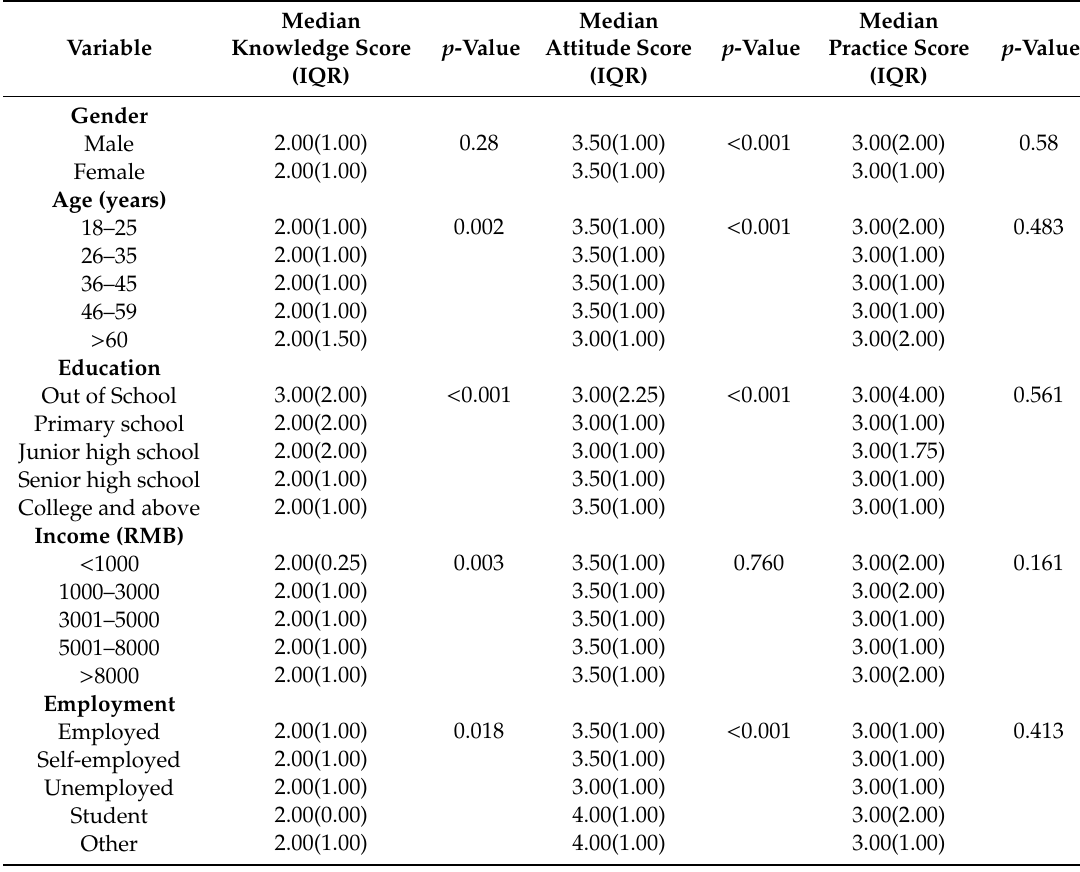
Table 5. Median score association with demographics ( n =